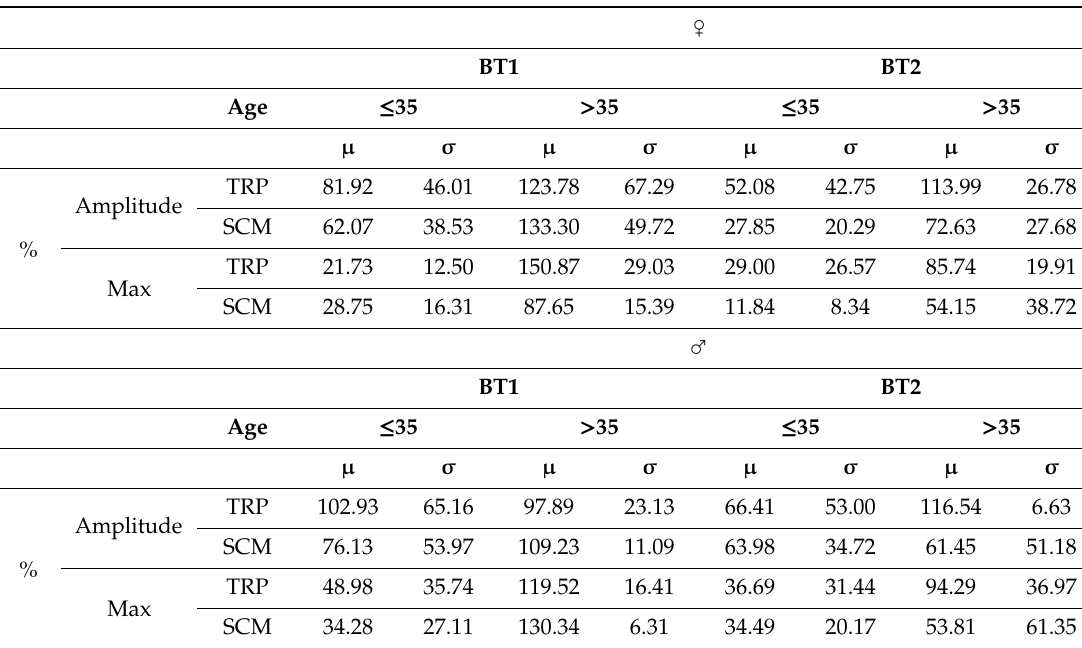
Table 5. Summary of the sEMG data from the experiments sorted by age and gender: Braking Test 1 (BT1) and Braking Test 2